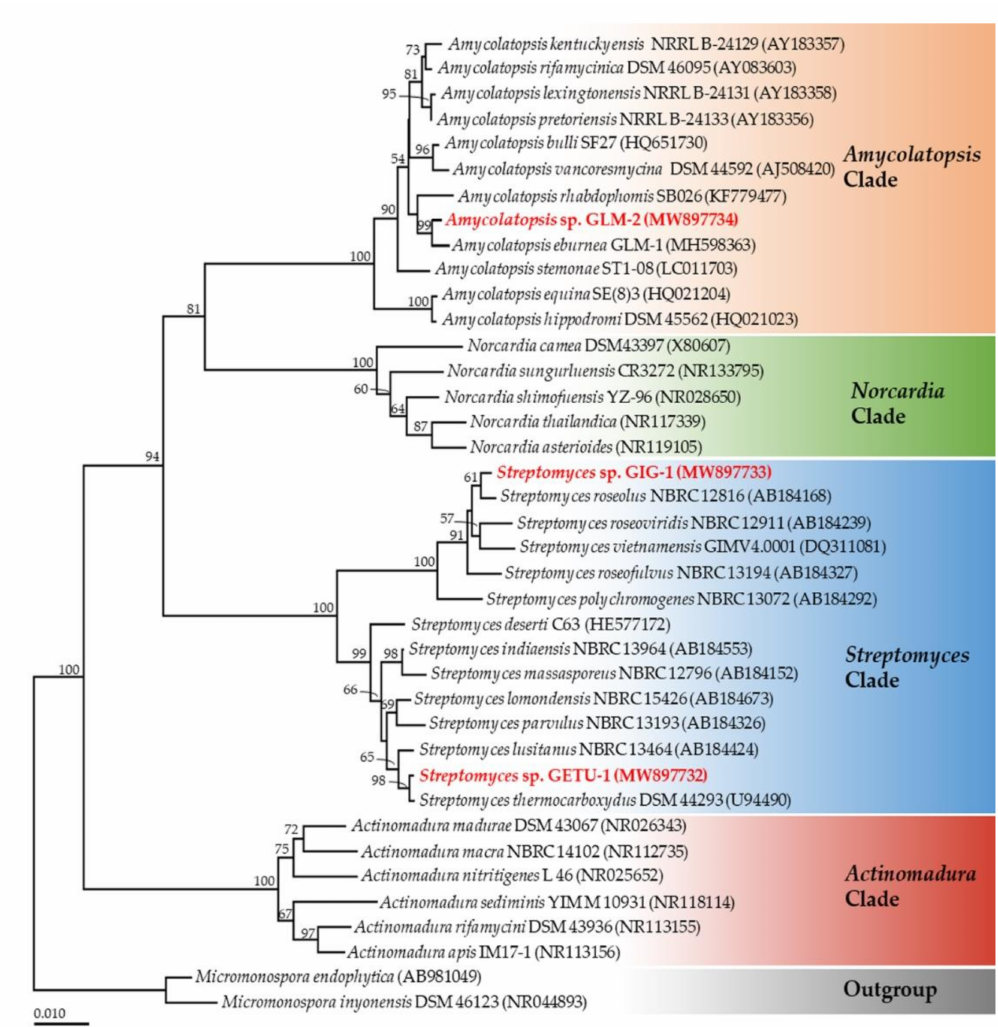
Figure 2. Phylogenetic tree based on 16S rRNA gene sequence with the neighbor-joining method. Micromonospora endophytica and M. inyonensis were used as outgroups. The number in each branch shows the bootstrap percentage (only values of more than 50% are shown). Bars represent 0.01 substitutions per nucleotide position. Actinobacterial strains obtained in this study are highlighted in